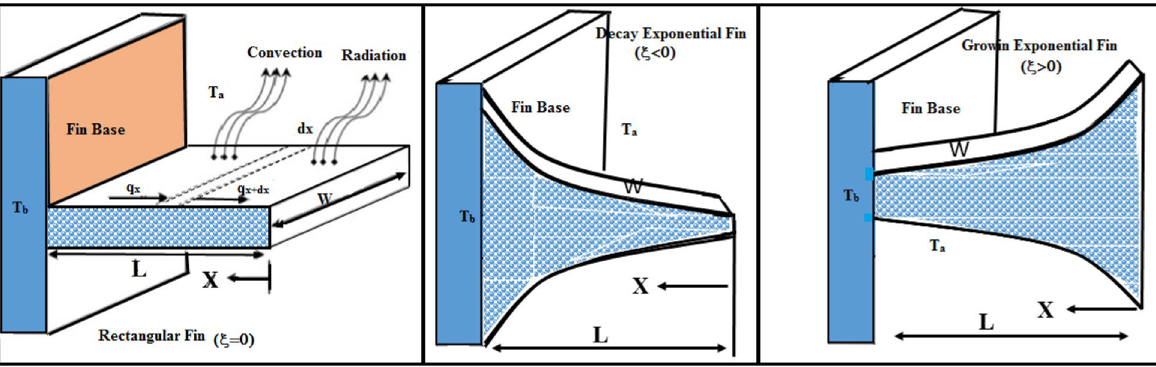
Figure 1. Schematic diagram of rectangular fin, decay and growing exponential